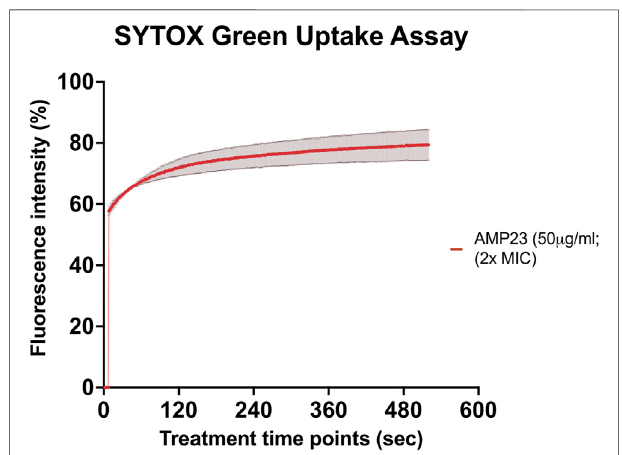
FIGURE 2 | Membrane permeabilising action of CaD23 against S. aureus ATCC SA29213 determined by SYTOX green uptake assay. The graphdemonstratingrapidmembranepermeabilisingactionofCaD23(50 μ g/ ml; 2x MIC) against SA29123, with a 60% increase in fl uorescence intensity (due to SYTOX green uptake) within seconds of treatment and plateaued at ∼ 80% fl uorescence intensity at 8 min. The fl uorescence intensity is presented as mean ± standard deviation (depicted in error bars) of two independent experiments. The maximum fl uorescence intensity (100%) was derivedfrom thepositivecontrol, Triton-X 0.1% (v/v). Fluorescence intensity(I) of the peptide-treated suspension was calculated and plotted as: (I peptide / I Triton-X(max) ) × 100%. The study was conducted as three independent